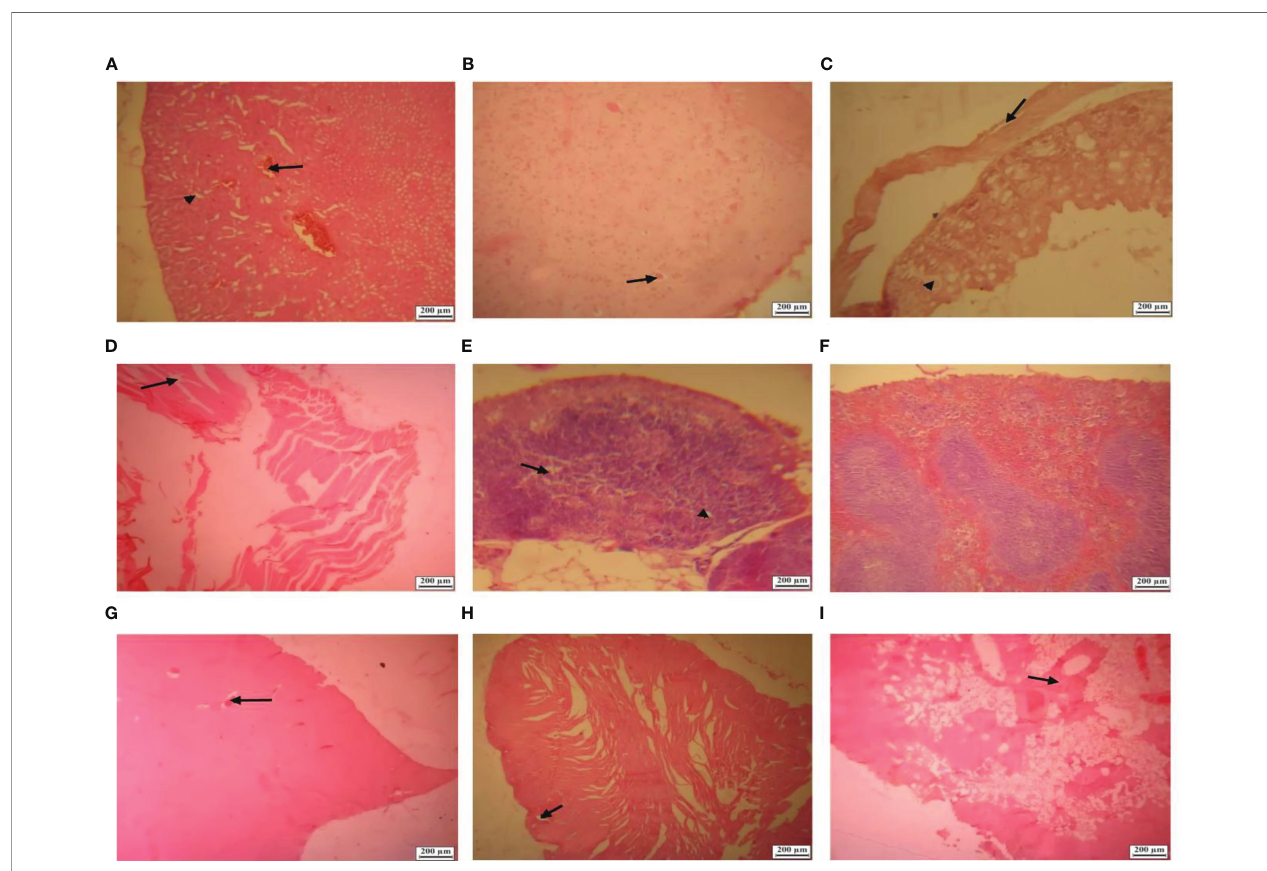
FIGURE 1 | Histological lesions in BALB/c mice tissues in high toxic dose of candidate vaccine (20µg). (A) Section from a kidney showing hyperemia (arrow), intratubular edema and multiple foci of edema (arrowhead) in kidney parenchyma (Hematoxylin and eosin×100). (B) Section from a brain showing small foci of perineuronal edema (arrow) (Hematoxylin and eosin×100). (C) Section from an intestine showing villous atrophy (arrowhead), submucosal edema (arrow) and vacuolated enterocytes (Hematoxylin and eosin×100). (D) Section from an injection site showing edema between muscles bundles (arrowhead) (Hematoxylin and eosin×100). (E) Section from a mediastinal lymph node showing lymphatic depletion (lymphoid reduction), decreased paracortical lymphocytes (arrow) and small foci of edema (arrowhead) (Hematoxylin and eosin×100). (F) Section from a spleen showing no lesion (Hematoxylin and eosin×100). (G) Section from liver showing foci of hyperemia (arrow) in the sinusoids and parenchymal edema with mild fatty degeneration (Hematoxylin and eosin×40). (H) Section from heart showing mild hyperemia between cardiac muscle fi bers (arrow) (Hematoxylin and eosin×40). (I) Section from lung showing parenchymal and vascular sections hyperemia as well as serous secretions (arrow) and increasing in alveolar septa (Hematoxylin and